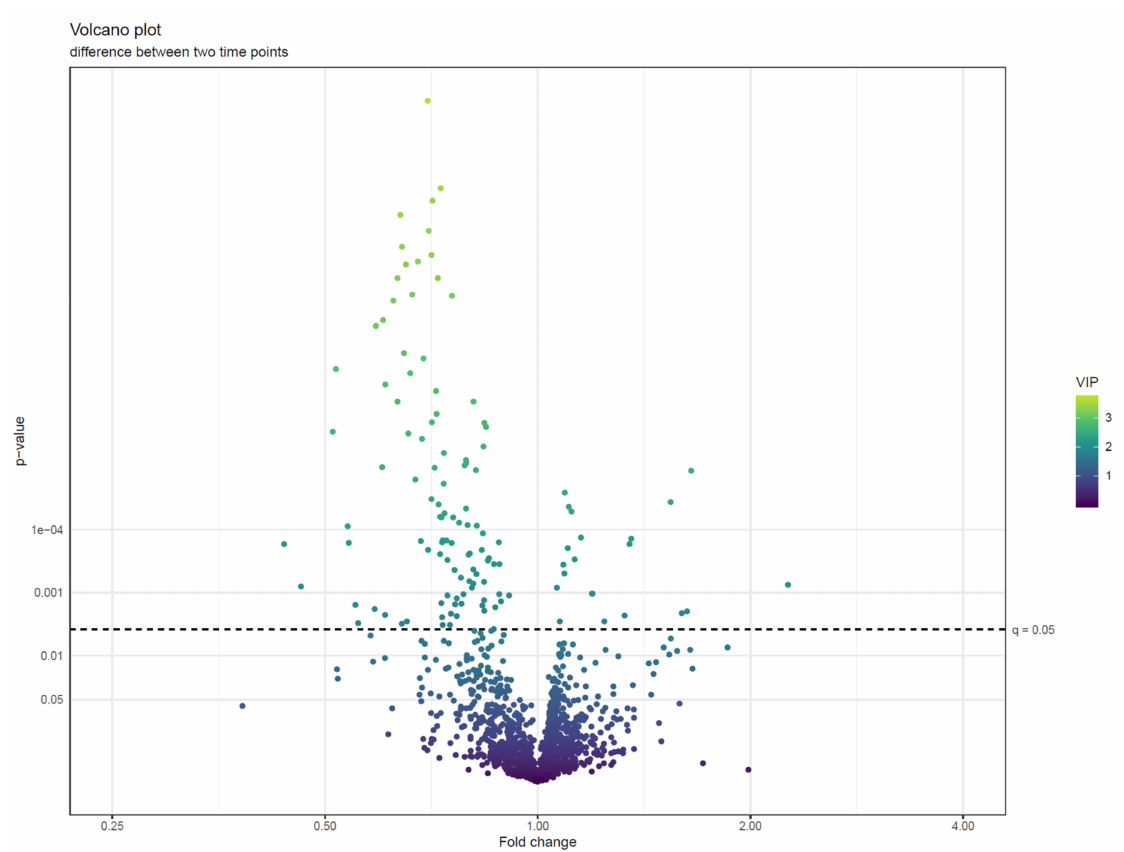
Figure 22. A volcano plot of p -values (negative log10 scale) from linear models testing the di ff erence of feature abundances between two time points against fold changes between samples taken before and after a dietary intervention (log2 scale). The features are colored by variable importance in projection (VIP)-value from a partial least squares-discriminant analysis (PLS-DA) model trained to separate the two time points. We can observe that the features with the smallest p -values tend to have fold changes below 1, indicating that they are less abundant at the end of the intervention. Other metrics of e ff ect size, like Cohen’s d values, can also be used in volcano